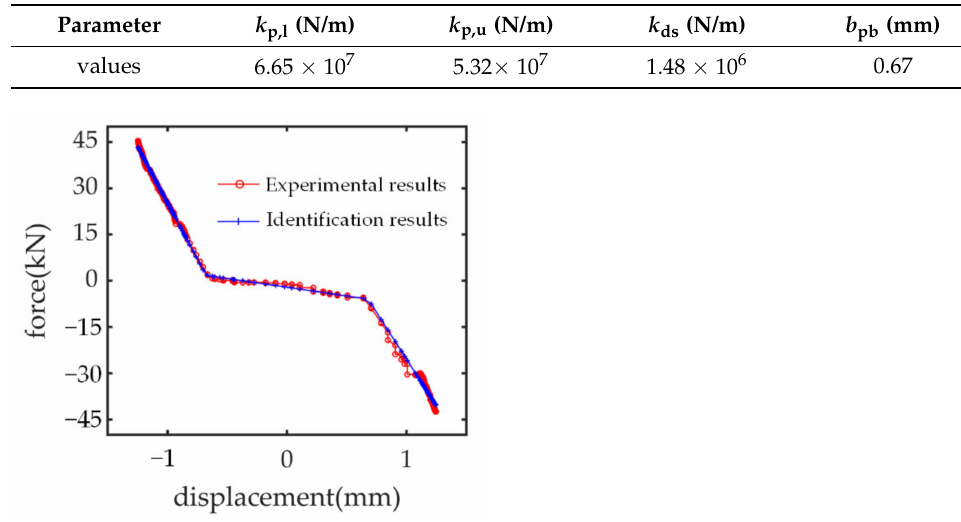
Table 1. Identification results of stiffness parameters.